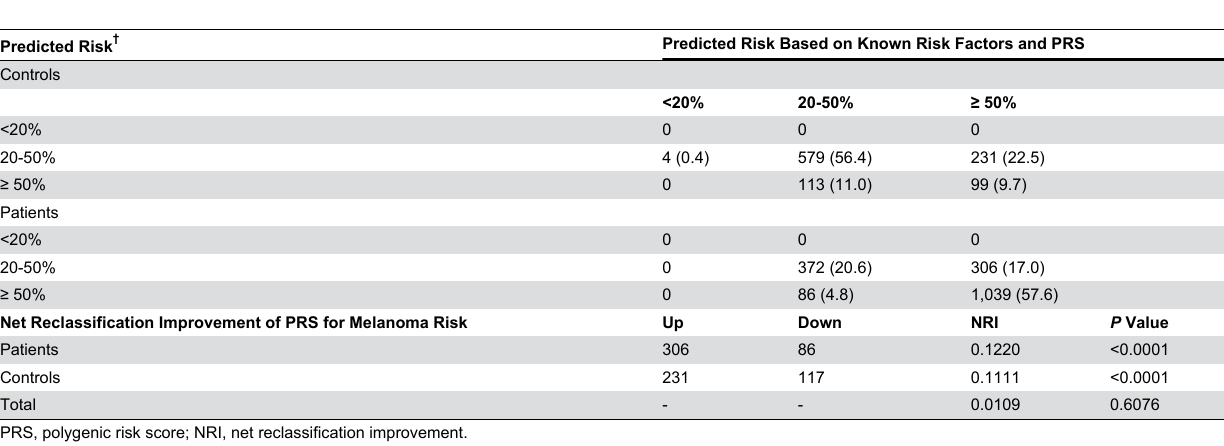
Table 5. Reclassification of participants’ predicted melanoma risk with and without weighted genetic variants in MD Anderson Study *